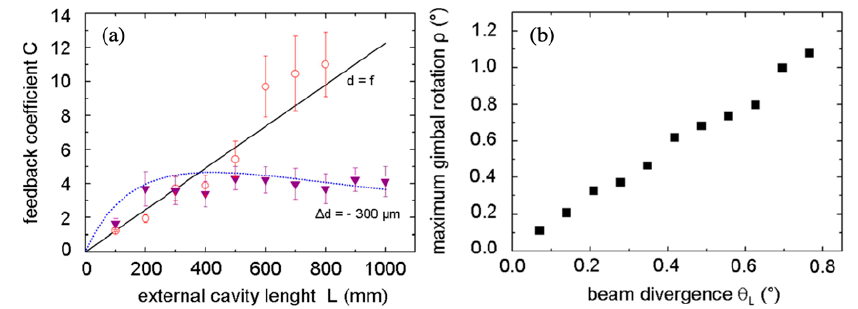
Figure 5. ( a ) Variation of feedback coefficient C for a collimated (d = f) and a divergent ( Δ d = − 0.3 μ m) Gaussian beam. ( b ) Maximum measurable tilt angle of a target at 1 m distance from the laser emitting a divergent Gaussian beam (adapted from Reference [35]).